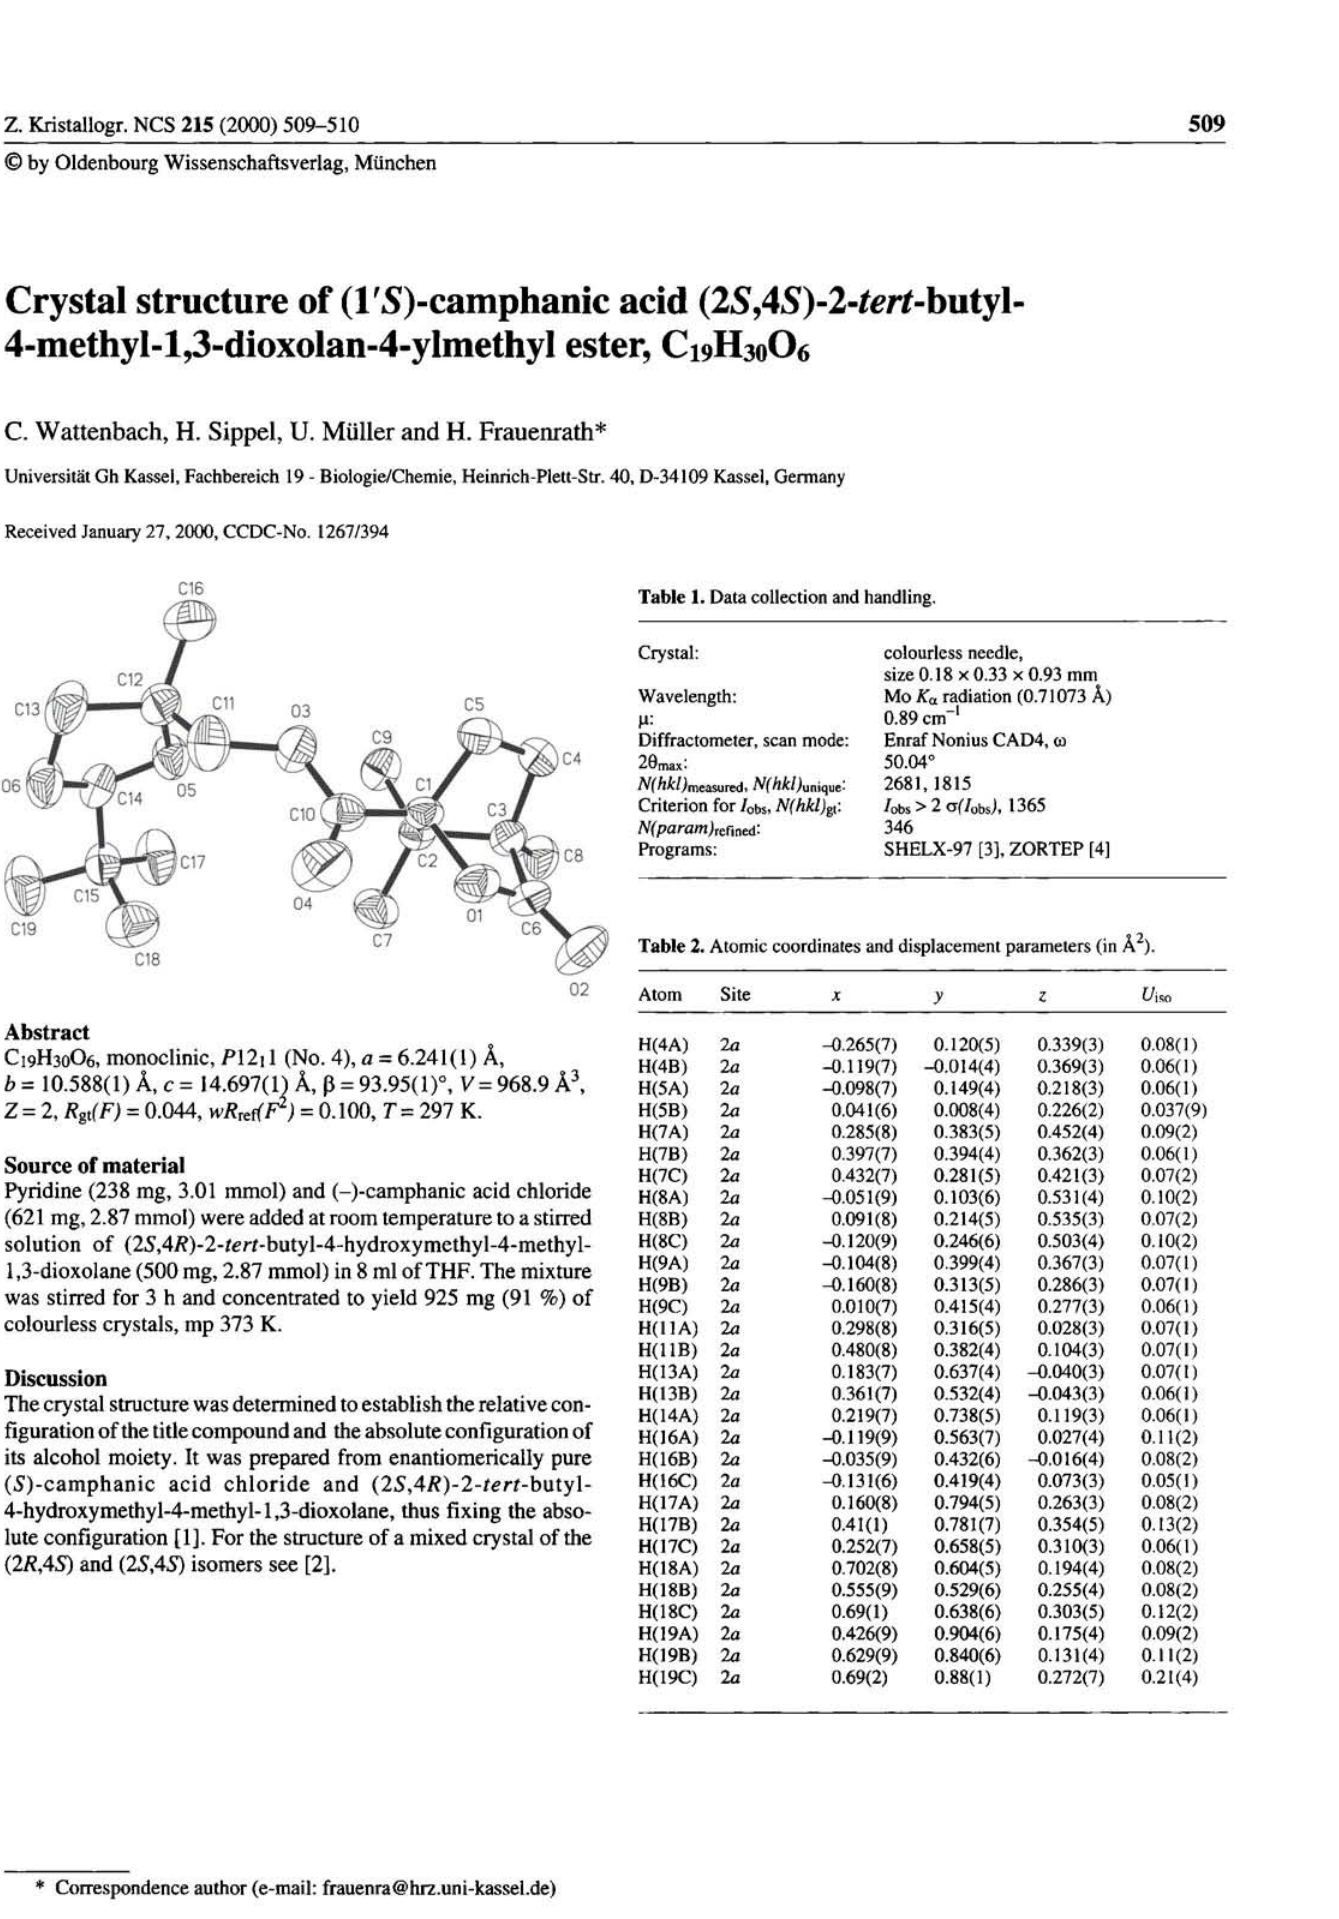
Table 1. Data collection and handling.